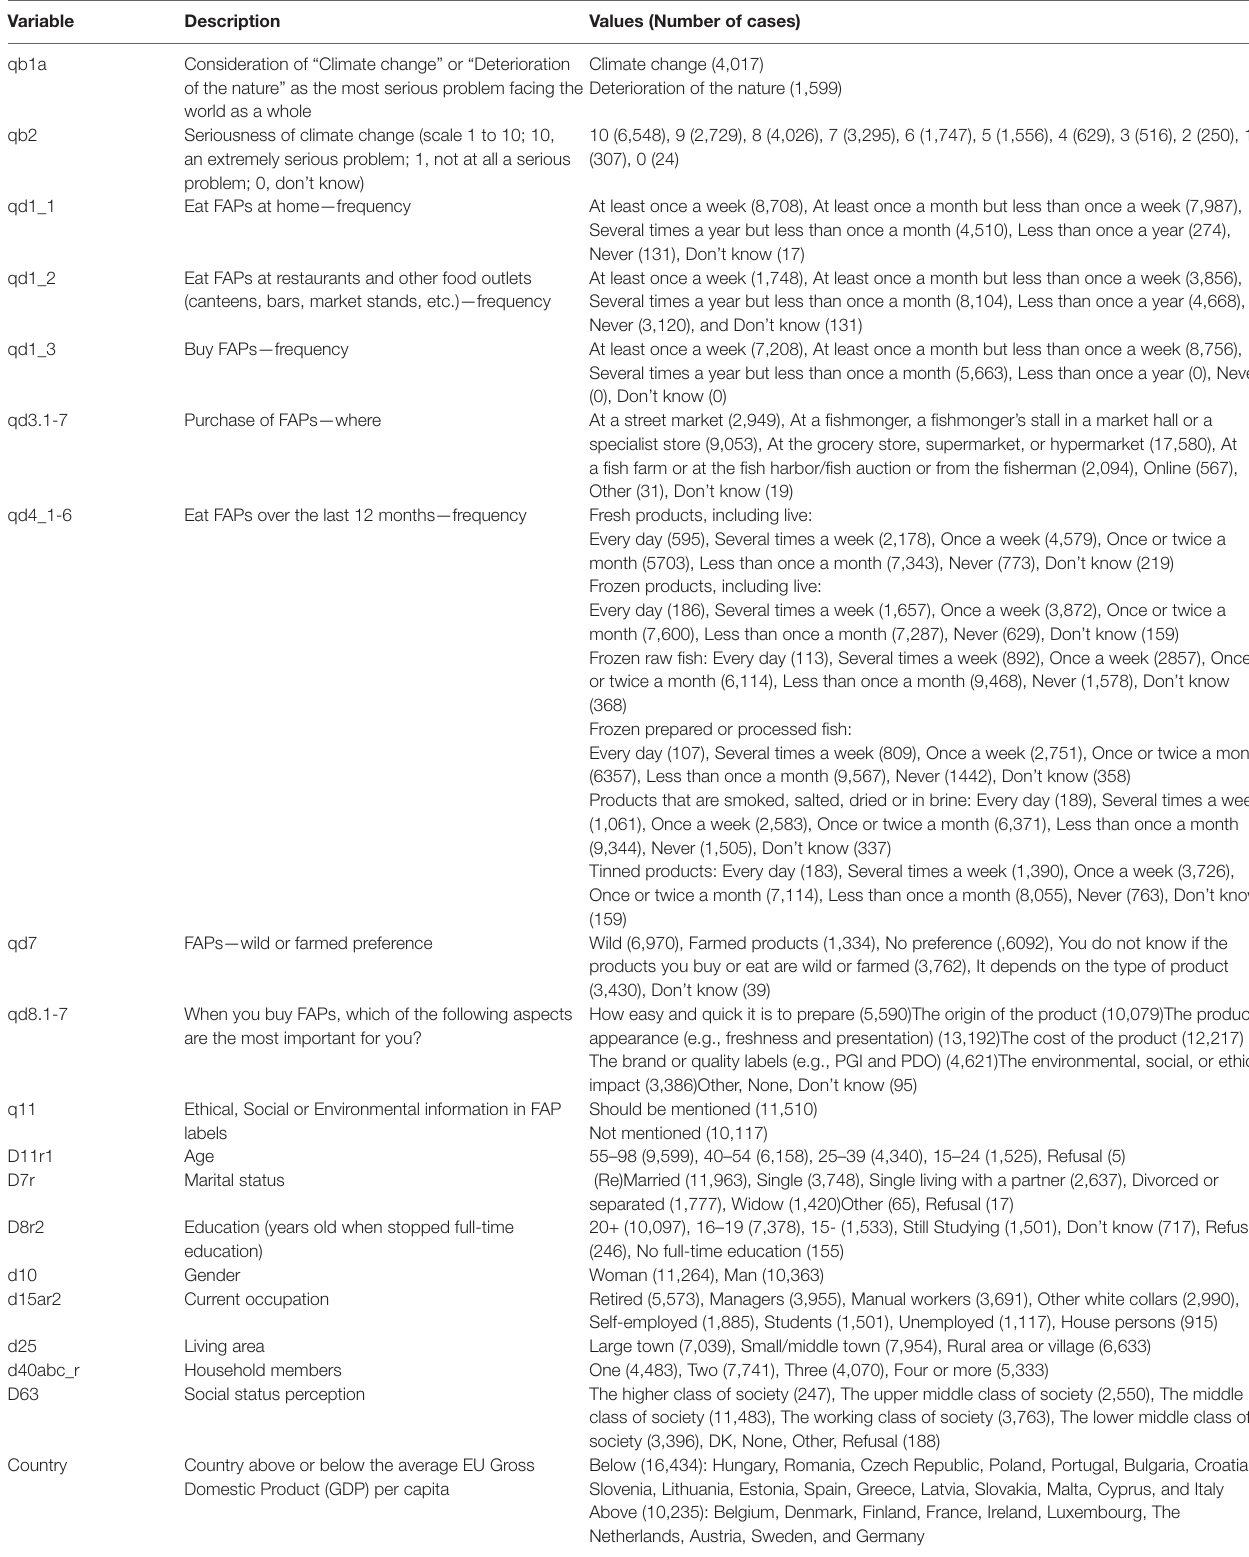
TABLE 1 | Variable description, values, and